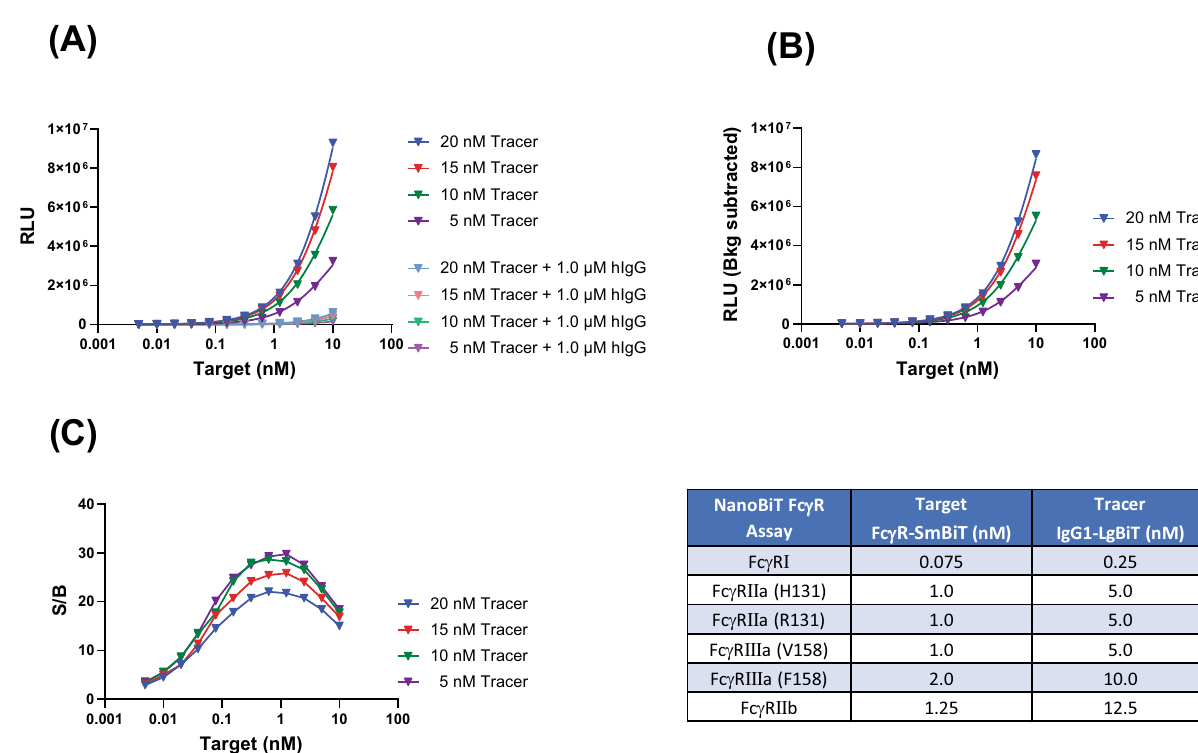
Figure 2. Representative data for the tracer-target titration shown for FcγRIIIa (V158). ( A ) Concentration dependent increase in luminescent signal as function of FcγRIIIa (V158)-SmBiT target and IgG-LgBiT tracer. Presence of excess human IgG competes with the tracer resulting in decrease in luminescent signal. Luminescent signal in the presence of excess human IgG is considered background and arises from random interaction between SmBiT and LgBiT. Data was generated in a 96-well plate in single replicate. ( B ) Background subtracted luminescence signal represent specific interaction between target and the tracer. ( C ) Signal/ background (S/B) ratio is calculated at each tracer target concentration and a specific concentration of tracer and target is selected (shown in the Table) for subsequent assays that satisfies the Cheng-Prusoff equation and offers high luminescence signal so that assay can be performed on any